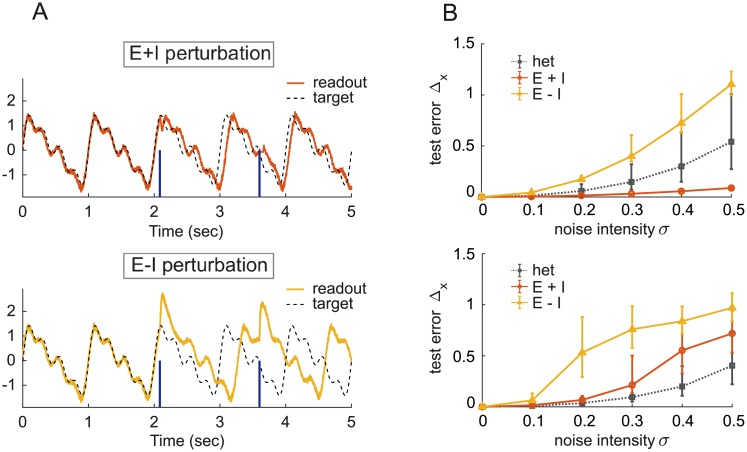
Response to perturbations in trained balanced networks.A: An E/I spiking network of size N = 200 trained on an oscillation task receives strong input pulses at random times (dark blue vertical lines), either in the E+I direction (top) or in the E-I direction (bottom). B: Median test error of two types of rate networks of size N = 200 trained to produce the same output signal as in A. Errorbars indicate 25% and 75% percentiles over 100 networks and 50 realizations of input white noise with intensity σ. The networks are driven either by N independent white noise inputs (black curve, legend: het) or by a single common white noise input in the E+I (red curve, legend E+I) or E-I (yellow curve, legend E-I) direction. Top: dynamically balanced network; bottom: parametrically balanced network with zero external input. Halftanh activation function, see Eq (9) for the definition of Δx.